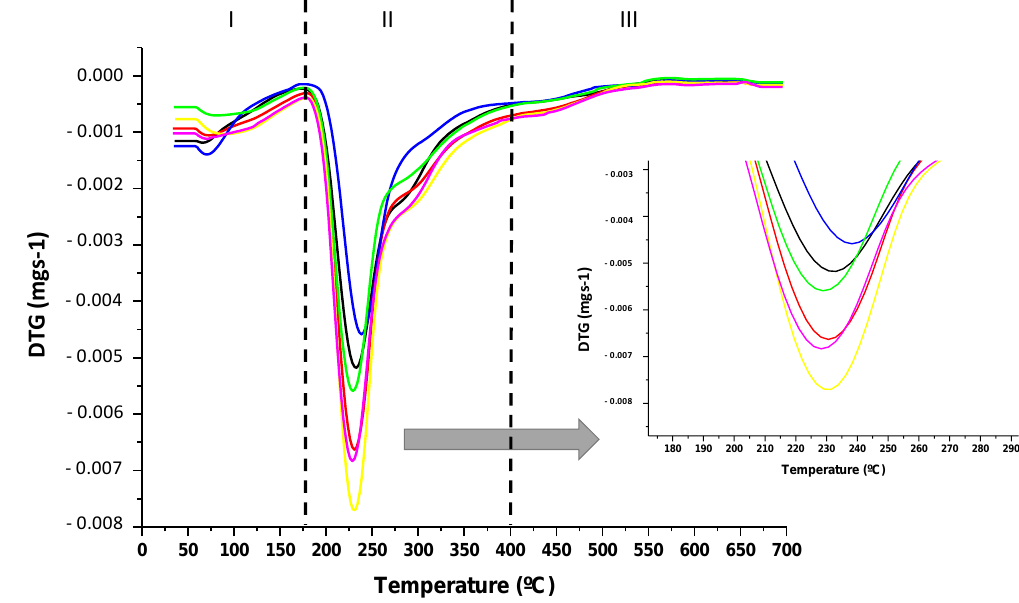
Figure 1. DTG curves of pectin-based films: PC (------), PC-1ZnO (------), PC-3ZnO (------), PC-5E (------), PC-5E-1ZnO (------) and PC-5E-3ZnO (------).